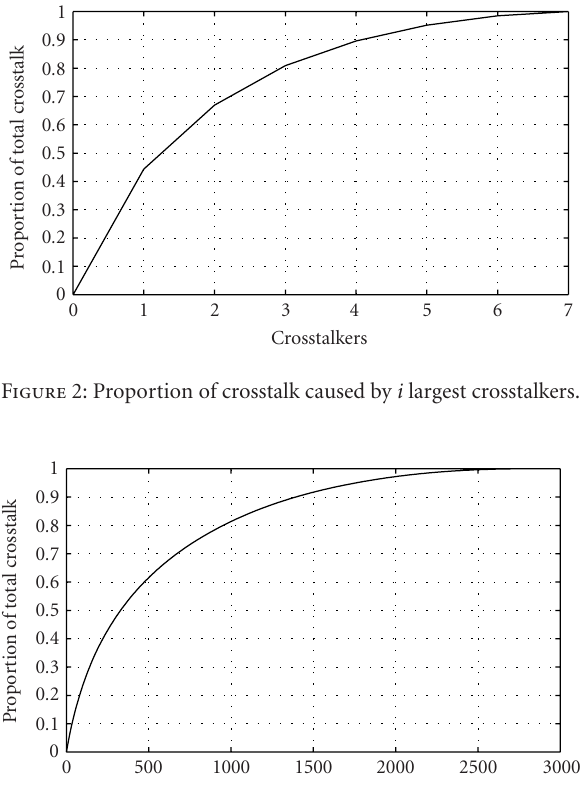
crosstalk energy is caused by the 4 largest